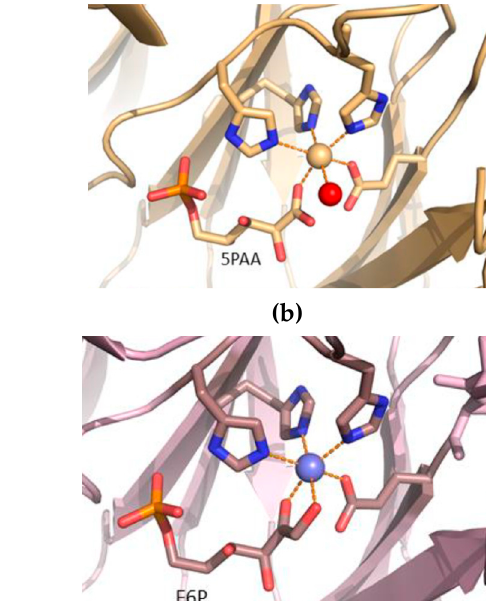
Figure 6. Mn 2+ coordination in the mutant PfPGI structures. For all mutant structures, the Mn 2+ ion (purple sphere) is coordinated in an octahedral arrangement: ( a ) Mutant AD (blue), (PDB code: 4LUL); ( b ) mutant RG (wheat), RG (PDB code: 4LTA); ( c ) mutant AG (yellow), (PDB code: 4LUK); and ( d ) mutant VY (pink), (PDB code: 4LUM), respectively. 5PAA and F6P shown as sticks.